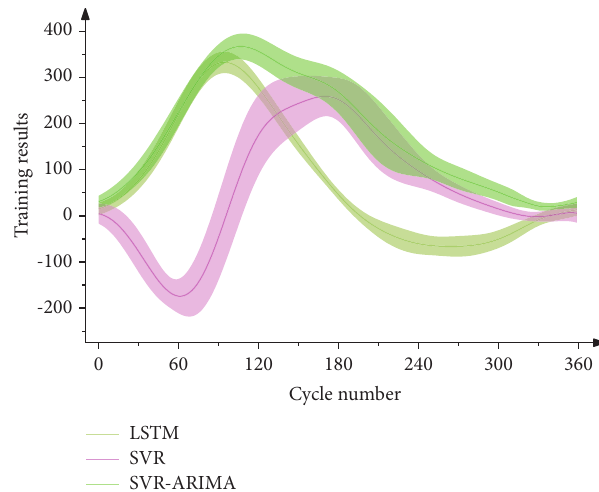
Figure 6: Training results under the first three types of feature system of weighted support vector machine.